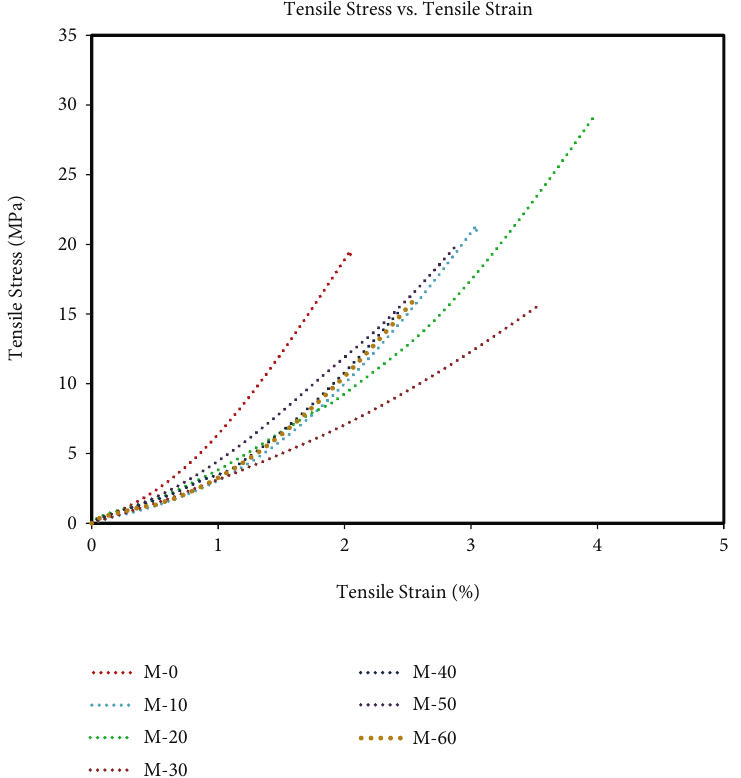
Figure 10: Stress – strain diagram for di ff erent composite